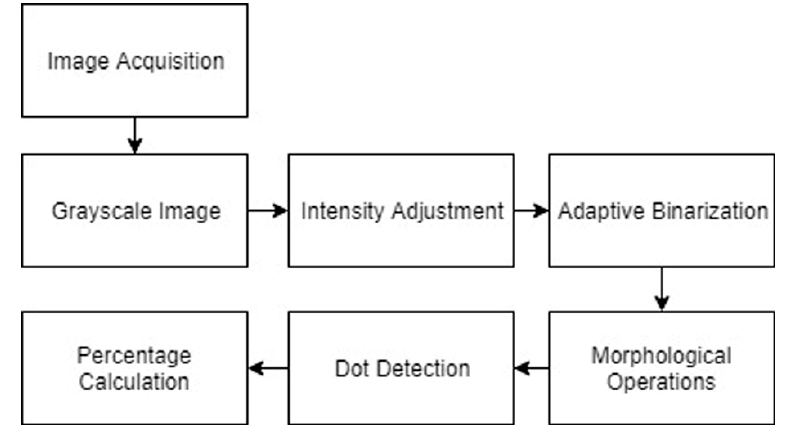
Figure 4. Steps of the image processing method.